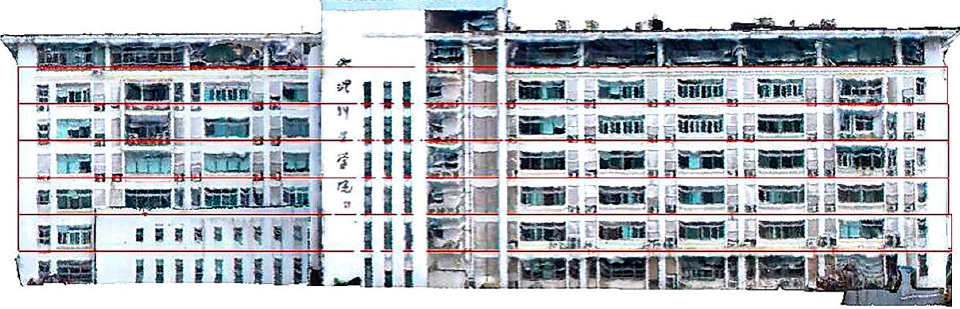
Figure 8. Partitioned results of building floors (red horizontal lines represent building floors).